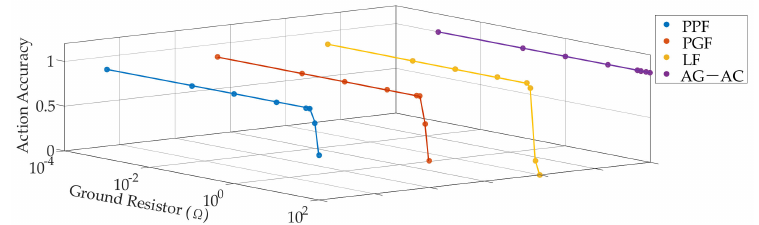
Figure 17. The influence of ground resistor on the action accuracy.